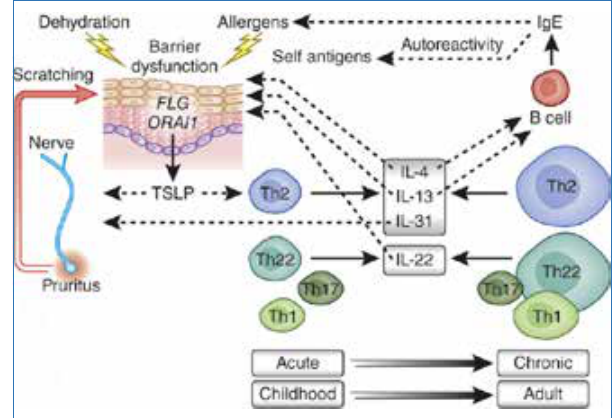
Figure 5. Pathogenesis of AD 3 TSLP, thymic stromal lymphopoietin FLG,